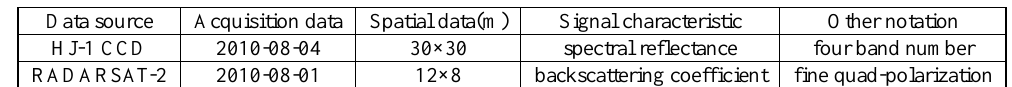
Table 1. Overview of RADARSAT-2 image and HJ-1 CCD image